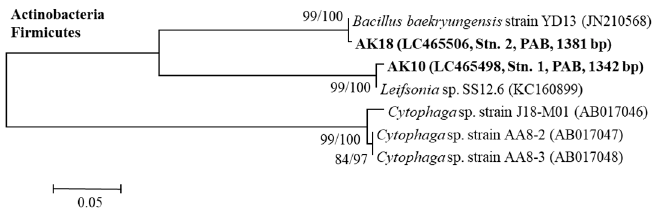
Figure 13. Phylogenetic tree for Actinobacteria and Bacilli (Firmicutes) of 16S rRNA gene sequences (~1300 bp). See the Figure 11 legend for the explanation of the tree.